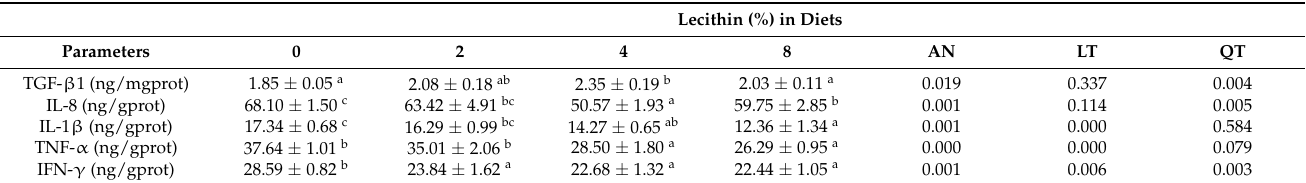
Table 9. Effects of dietary soybean lecithin on the anti-inflammatory and pro-inflammatory cytokines in the intestine of largemouth bass. Lecithin (%) in